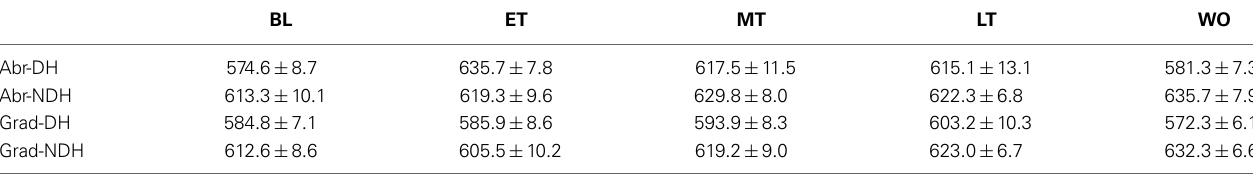
Table 1 | Movement time (ms) from the baseline block (BL), early training block (ET), middle training block (MT), late training block (LT), and the washout block (WO).